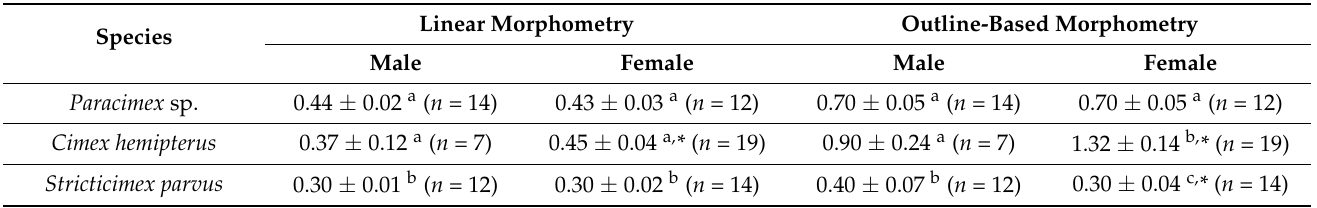
Table 1. Average values of log-size variables and semi-major axis for both sexes and per species from the linear and outline-based morphometry, respectively.